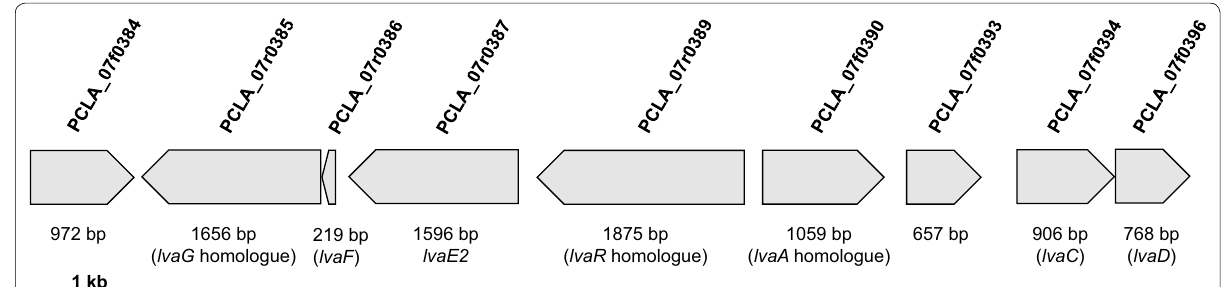
a Expression of genes after 3-day cultivation with LA were compared to that after 2-day cultivation with pyruvic acid (L3/P2)